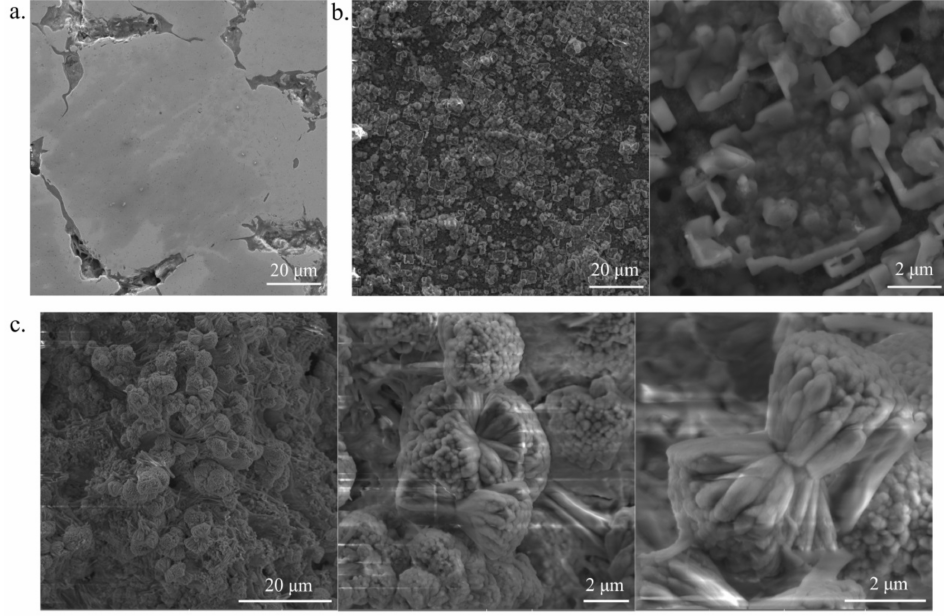
Figure 3. SEM micrographs for Ti31Mo before modification ( a ), after NaOH 60 ◦ C/24 h ( b ), and hydrothermal treatment ( c ).